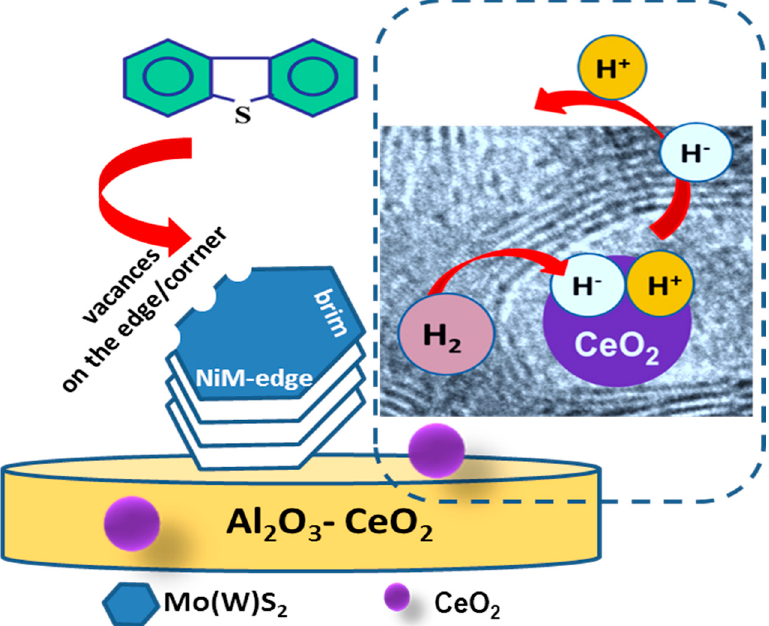
Figure 14. Schematic representation of the DBT HDS reaction mechanism on the surface of the best NiMoW/Al ‐ Ce15 catalyst showing the adsorption of DBT on the CUS sites of the NiMo(W)S phase and the mechanism of the heterolytic dissociation of H 2 on CeO 2 nanoparticles.